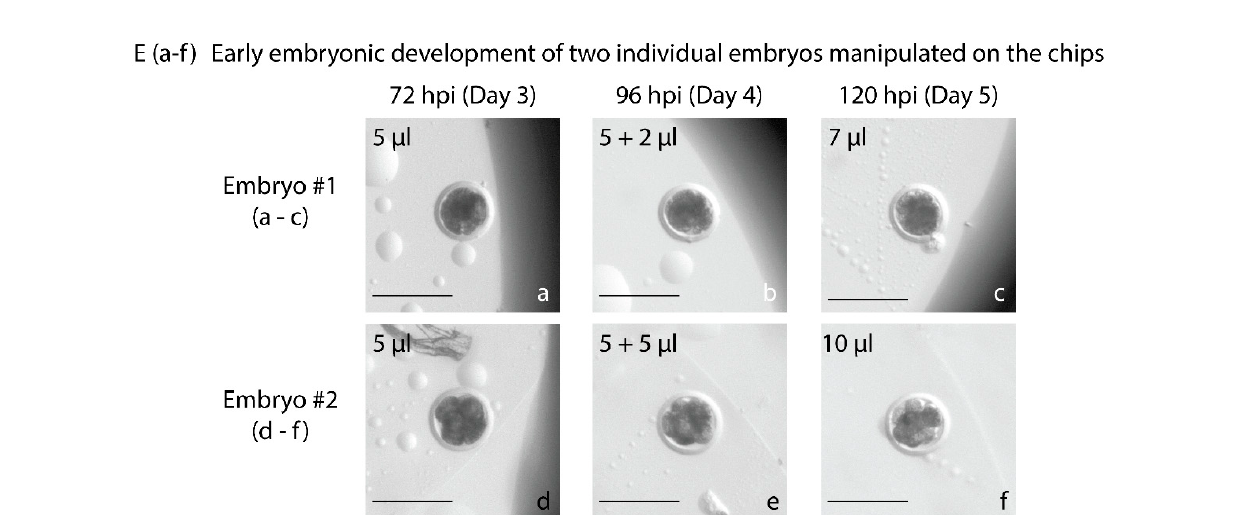
Figure 5. Static in vitro culture ( A – C ) and on-chip manipulation of bovine embryos ( D , E ). ( A , B ) show the cleavage and blastocyst rates of embryos cultured in groups I-III assessed at 48 and 192 hpi, respectively. No statistically significant differences in cleavage and blastocyst rates among the groups were found ( p > 0.05). ( C ) depicts the in vitro embryo development at 192 hpi (day 8): a hatching blastocyst in the control (group I), an expanded blastocyst in a 5 µL droplet on the Petri dish (group II), and an early blastocyst in a 5 µL droplet sandwiched on the chip (group III). Red scale bar = 200 µm. ( D ) Frames showing embryo loading on the chip at 48 hpi (DI–DIV). The edge of the top plate (ground electrode) as well as oil/air interface are visible in DI-DIII. Brie fl y, an embryo-containing droplet of culture medium enriched with Tween 80 (0.01%) is pipe tt ed between the bo tt om and top plates of the chip (DI–DII). Next, the droplet is moved away from the edge and air/oil interface by the application of 70 V to the bo tt om driving electrode while the top electrode is grounded (DIII–DIV). Green arrows indicate the location of the zygote. Green scale bar = 1000 µm. ( E ) depicts two embryos (a–c and d–f) manipulated on the chip and supplied with a 2 or 5 µL droplet of medium merged with the embryo-containing droplet at 96 hpi. Cleavage of two 4-cell embryos is presented until 120 hpi (day 5 of culture). Black scale bar = 200 µm.